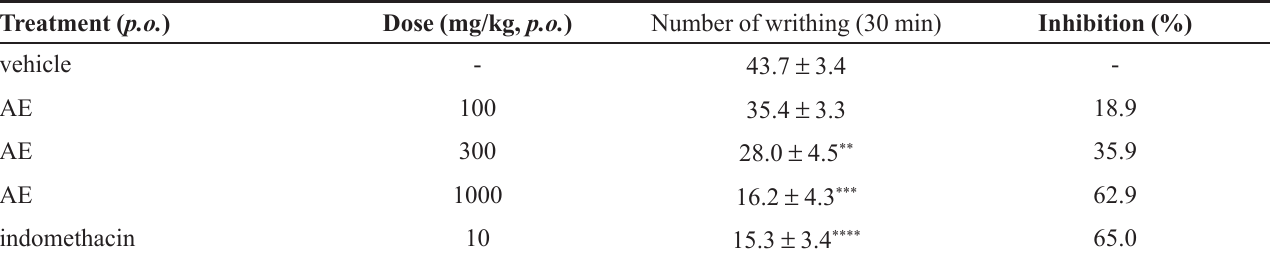
Values represent the mean ± S.E.M. of 6 mice. Significantly different from control group: ** p < 0.01, *** p < 0.001, **** p <